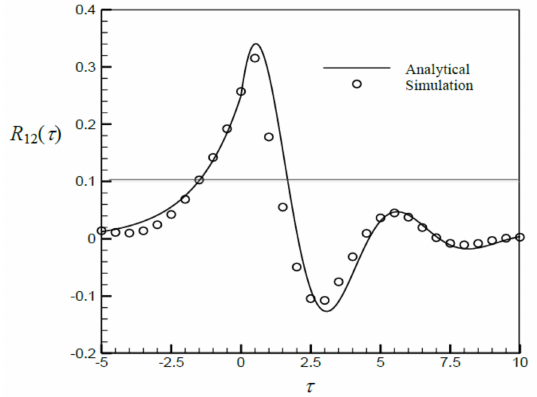
Figure 1. Cross − correlation function R 12 ( τ ) of X 1 ( t ) and X 2 ( t ) for Equation (9) using the linear filter method.